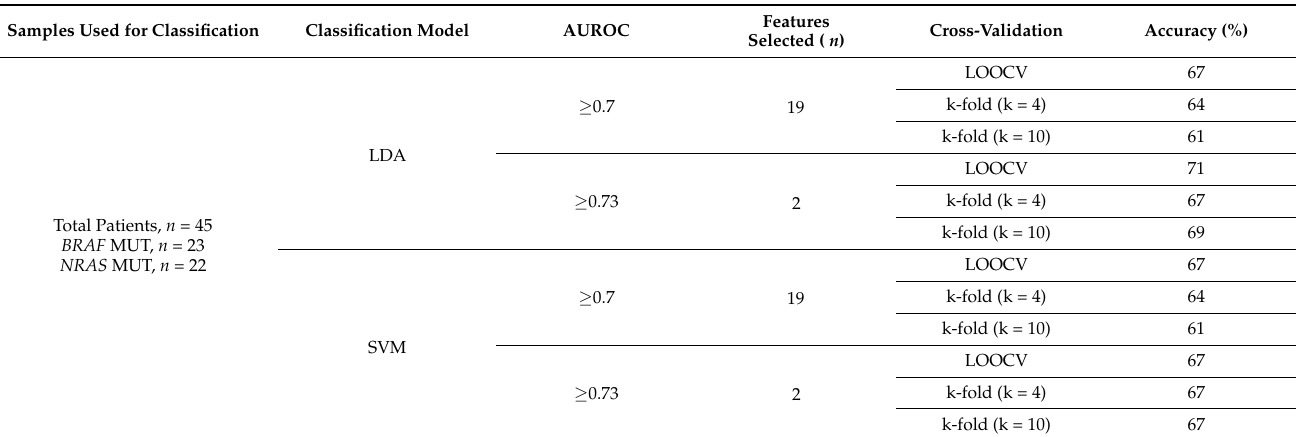
Table 6. Classification analysis to discriminate BRAF (v-raf murine sarcoma viral oncogene homolog B1) ( BRAF MUT) from NRAS (neuroblastoma RAS viral oncogene homolog) ( NRAS MUT)